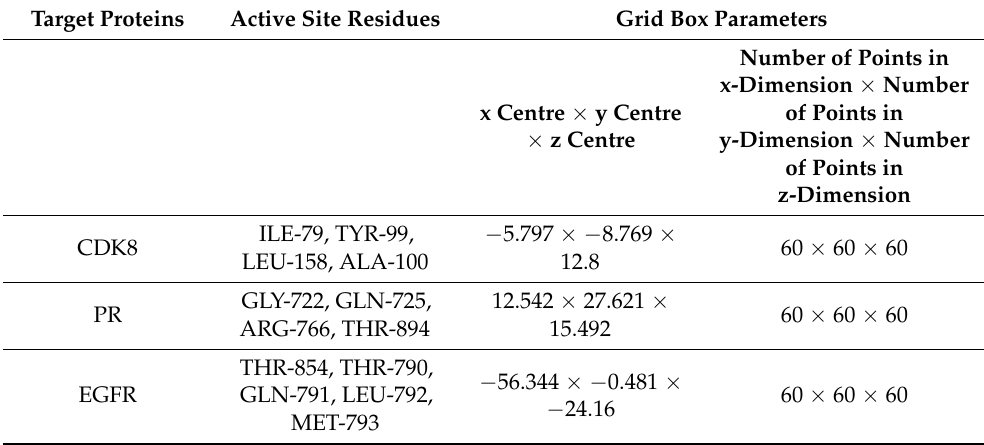
Table 5. Active site residues and grid box parameters selected for target proteins. Target